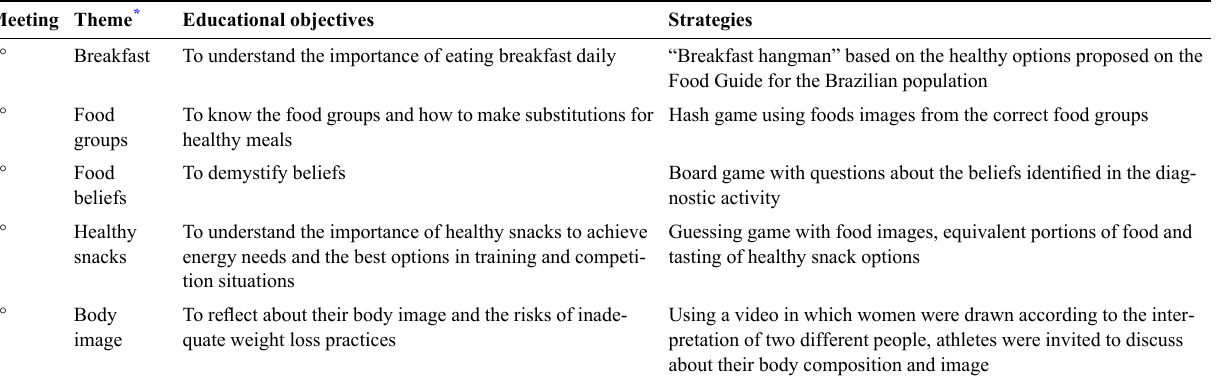
Table 1 - Topics, educational objectives and strategies adopted in each activity of the NHEP. Meeting Theme